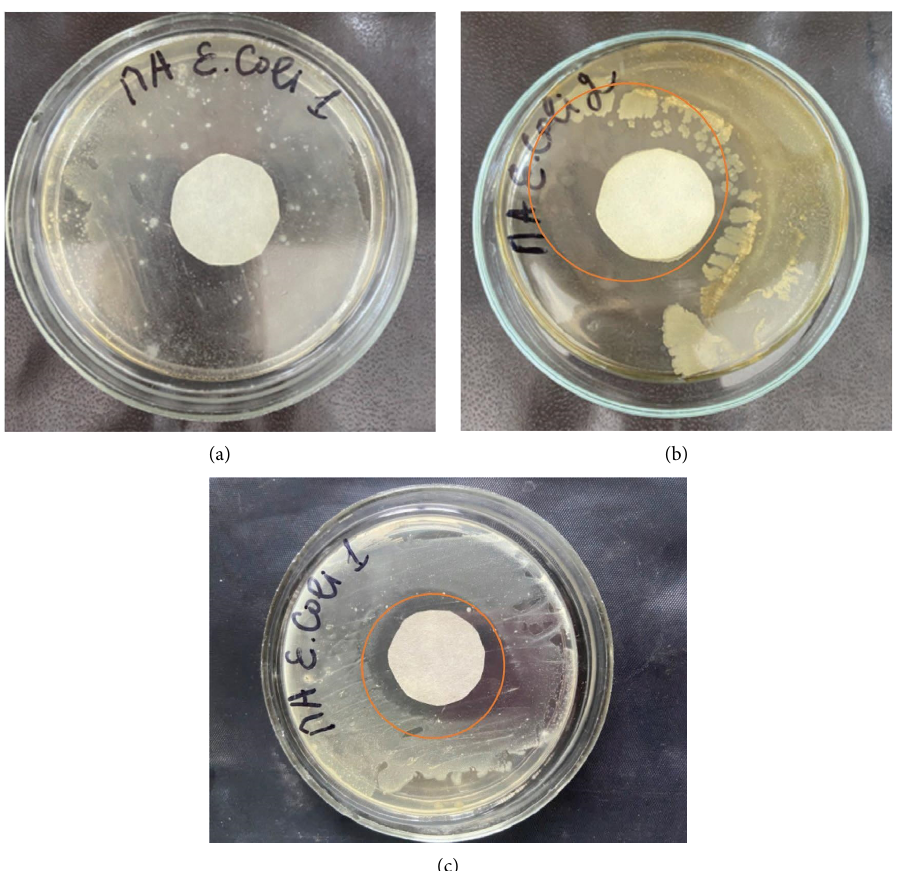
Figure 8: Antibacterial activity of “green” synthesized AgNPs via agar disk difusion in Gram-negative bacteria ( Escherichia coli ): (a) distilled water, (b) synthesized AgNPs with grape pomace extract obtained by P-GPE, and (c) antibiotic (aztreonam) (Petri dishes were incubated at 37 ° C for 24